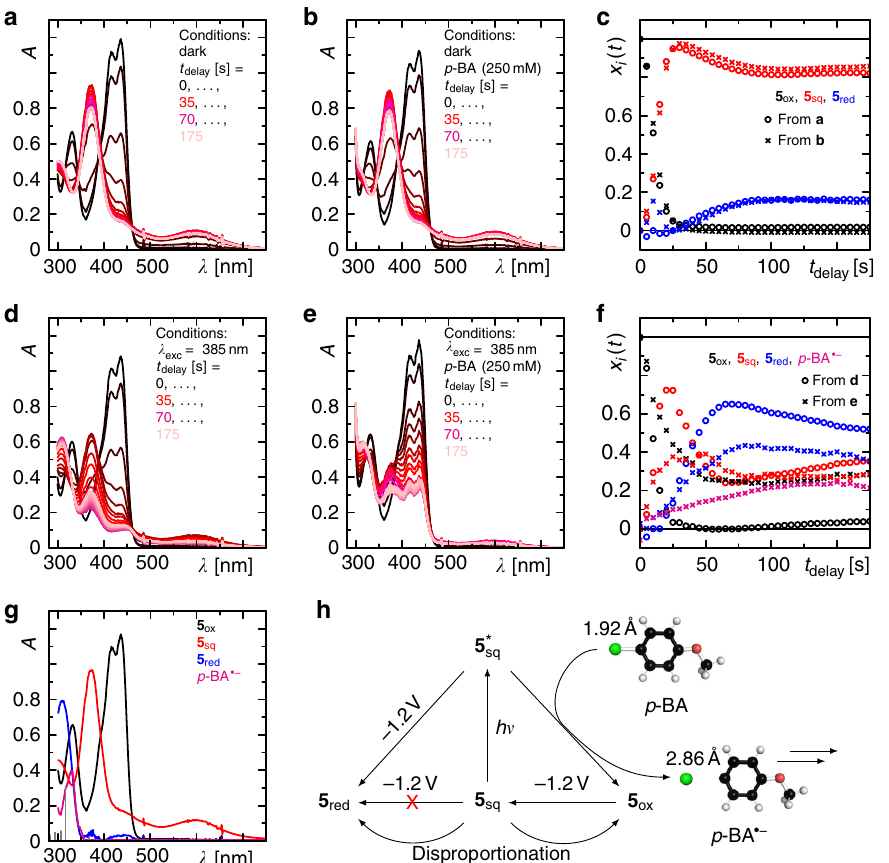
Fig. 5 Reactivity of electrochemically formed semiquinone 5 sq . a , b , d , e Sequences of UV/Vis absorption spectra after application of − 1.2 V to the sample at conditions as indicated. c , f Concentration – time pro fi les from fi tting the species spectra shown in g to the data as indicated. The grey vertical lines in g correspond to the quantum chemically calculated stick spectrum of p -BA (cid:129) ‒ as described in the text. h Summary of all the observed processes. The stick and ball structure of p -BA and p -BA (cid:129) ‒ are the result of quantum chemical calculations as described in the main text and Supplementary Note 11. The signi fi cantly reduced Br − dissociation energy in p -BA (cid:129) − demonstrates the fi nal bromine dissociation upon one electron